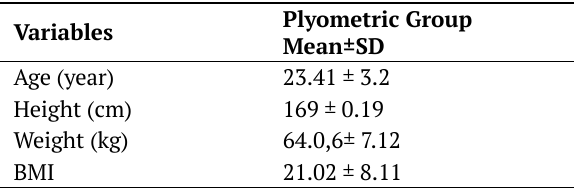
Table 1. Anthropometric characteristics of